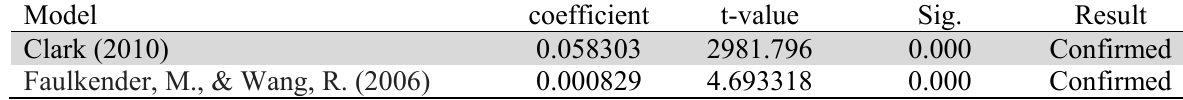
The results of examining the first hypothesis